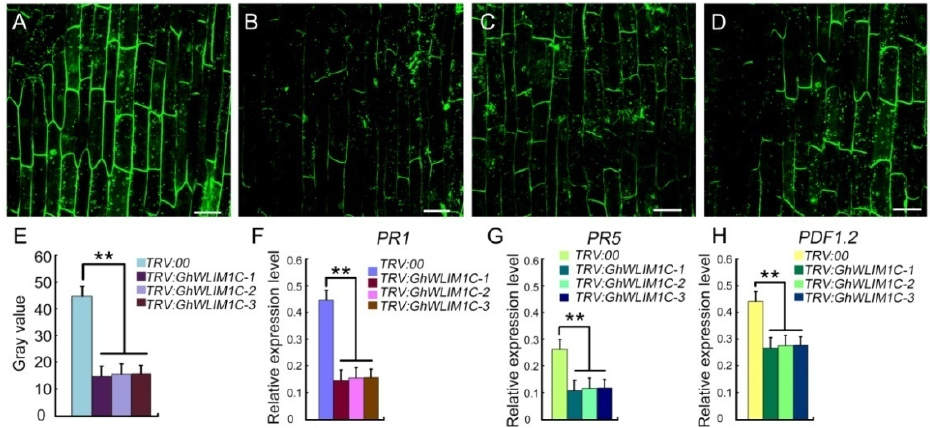
Figure 6. Defense response analysis of GhWLIM1C -silencing plants. ( A – D ) H2DCFDA staining of the ROS in root cells of the TRV:00 ( A ) and three GhWLIM1C -silencing ( B – D ) cotton plants at 72 hpi. Fluorescence of H2DCFDA was detected with confocal microscopy. Bars = 20 µ m. ( E ) Quantification of the fluorescence in ( A – D ). ( F – H ) qRT-PCR analysis of the expressions of defense-related genes, PR1 ( F ), PR5 ( G ) and PDF1.2 ( H ) in the root tissues of the TRV:00 and three GhWLIM1C silencing cotton plants at 72 hpi. Error bars represent the SD of three biological replicates ( n = 36), and asterisks indicate statistically significant differences, as determined by Student’s t -test (** p < 0.01).